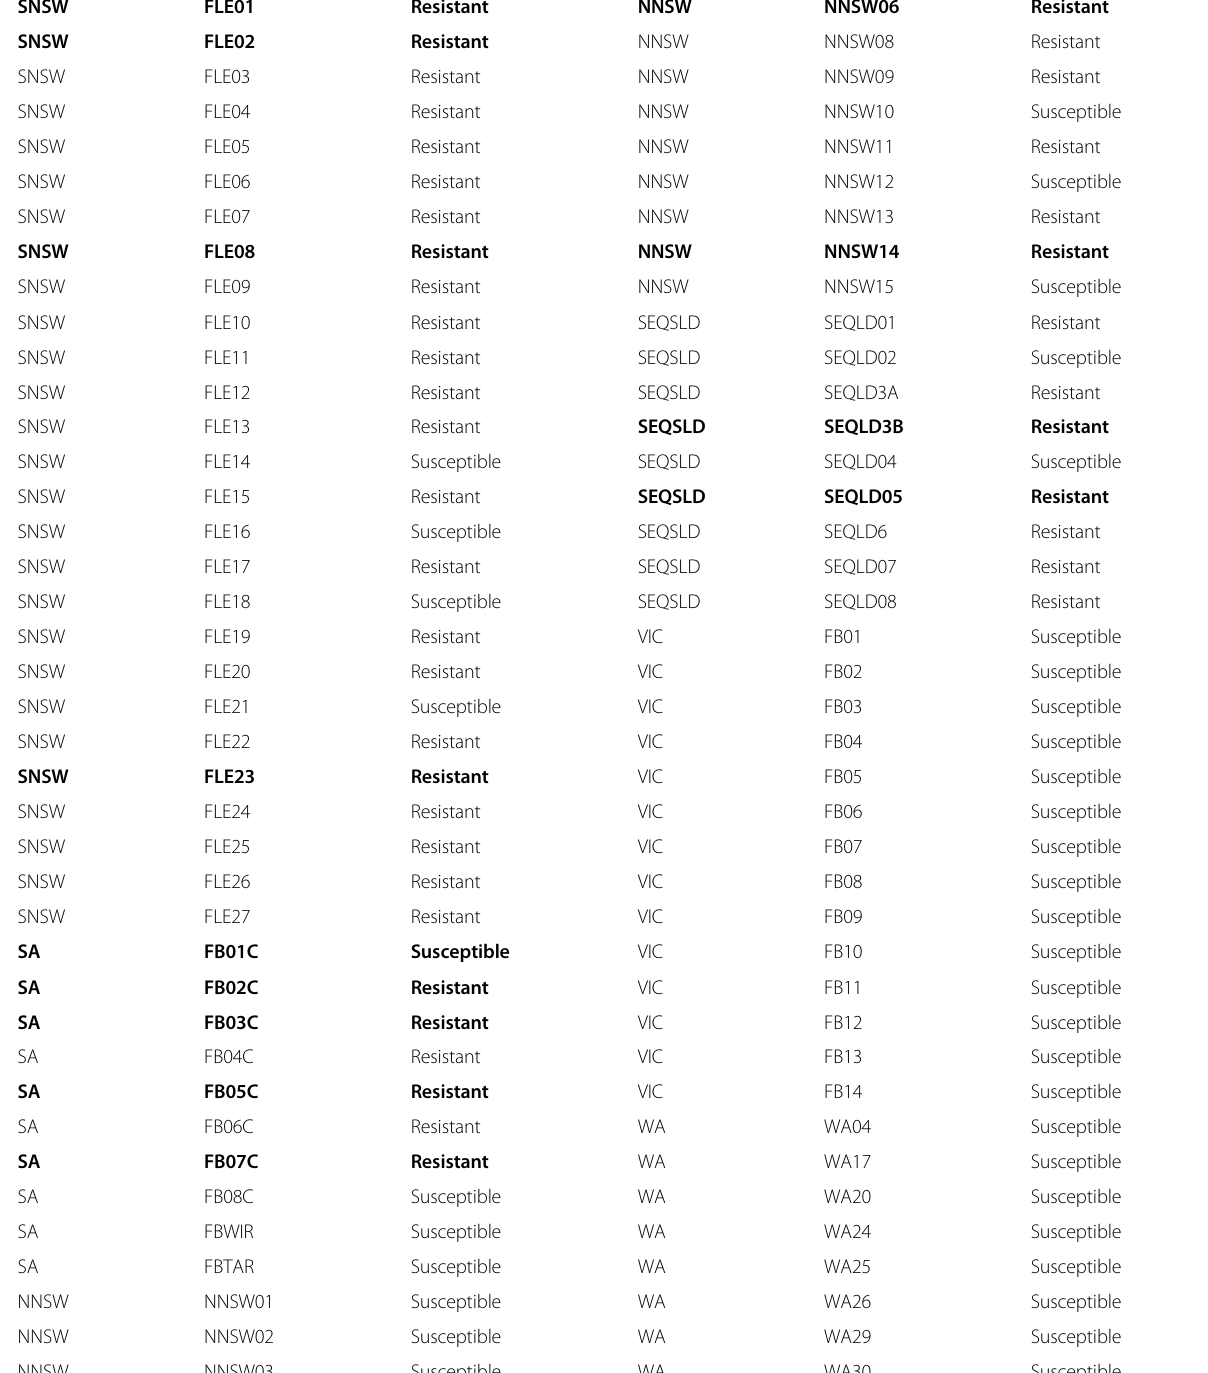
Table 1 Names, locations, and response to glyphosate of the 82 populations of flaxleaf fleabane used in this AFLP analysis. Data in boldface shows populations selected for the dose